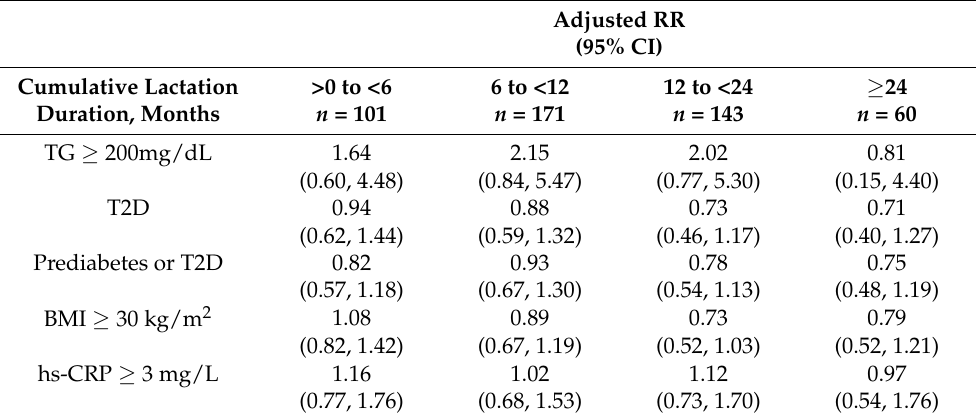
Table 3. Adjusted associations of cumulative lactation duration with dichotomous cardiometabolic outcomes 9–16 years after the index pregnancy among women with a history of gestational diabetes compared to no lactation, n =